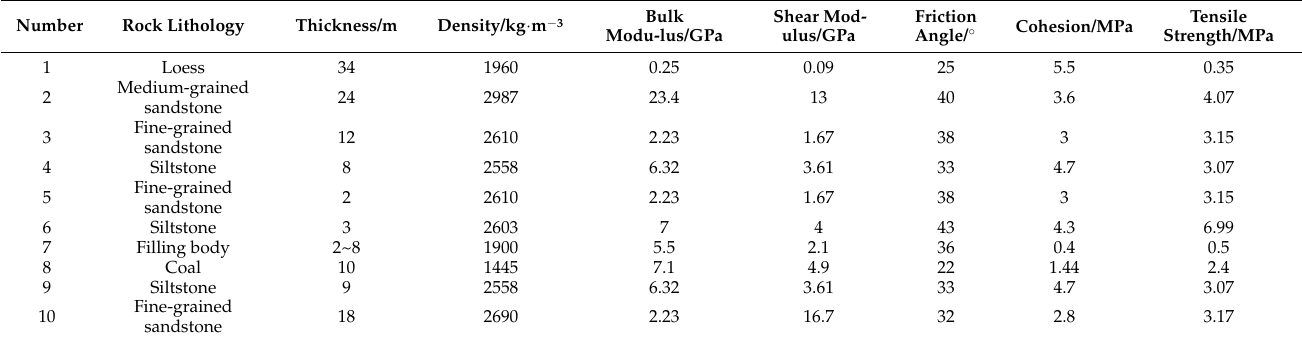
Table 1. Physical and mechanical parameters of coal and rock strata.